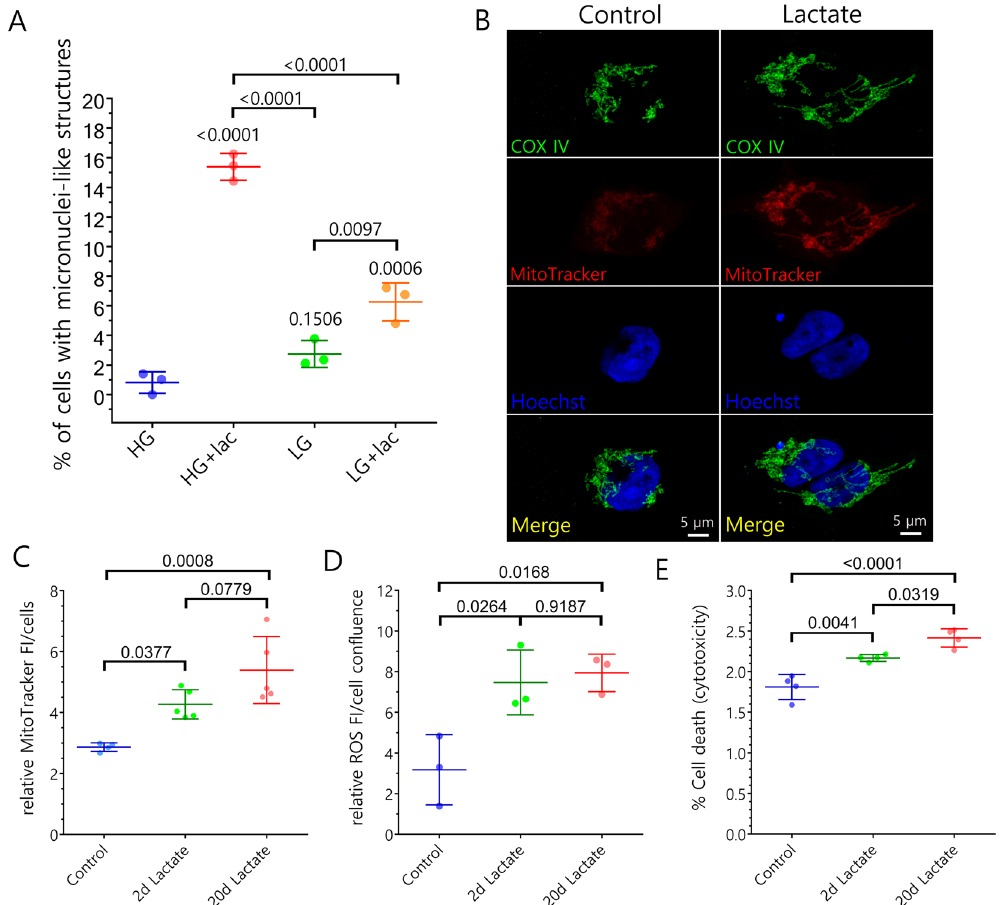
Figure 1. Metabolic stress induces the formation of micronuclei-like structures in HEK293T cells. ( A ) Quantification of micronuclei-like structures formation under different conditions (HG = high glucose; LG = low glucose; lac = lactate). Data are presented as mean ± SD and p values are indicated (two-way ANOVA analysis with Tukey post-hoc test; n = 3). ( B ) Representative confocal images of HEK293T cells under control or metabolic stress conditions during 20 days showing the difference in the fluorescence of MitoTracker Red CM-H 2 XRos as measure of the changes in mitochondrial membrane potential. Staining for COX IV was used as mitochondrial marker. Hoechst was used as nucleic acid marker. ( C ) Quantification of the fluorescence intensity (FI) of the oxidized form of MitoTracker Red CM-H 2 XRos under control conditions and after 2 and 20 days of metabolic stress induced by lactate. Only the oxidized form of MitoTracker is fluorescent and retained in the mitochondria as measure of the its metabolic activity. Data are presented as mean ± SD and p values are indicated (ANOVA analysis with Tukey post-hoc test; n control = 4; n treatments = 5). ( D ) Quantification of reactive oxygen species (ROS) analyzing the fluorescence intensity (FI) of oxidized intracellular carboxy- H 2 DCFDA after incubation under control conditions and after 2 and 20 days of metabolic stress induced by lactate. Only the oxidized form of carboxy-H 2 DCFDA is fluorescent and accounts for the amount of intracellular ROS under the studied conditions. Data are presented as mean ± SD and p values are indicated (ANOVA analysis with Tukey post-hoc test; n = 3). ( E ) Cytotoxicity assay showing the percentage of dead cells under control conditions and after 2 and 20 days of metabolic stress induced by lactate. Data are presented as mean ± SD and p values are indicated (ANOVA analysis with Tukey post-hoc test; n =